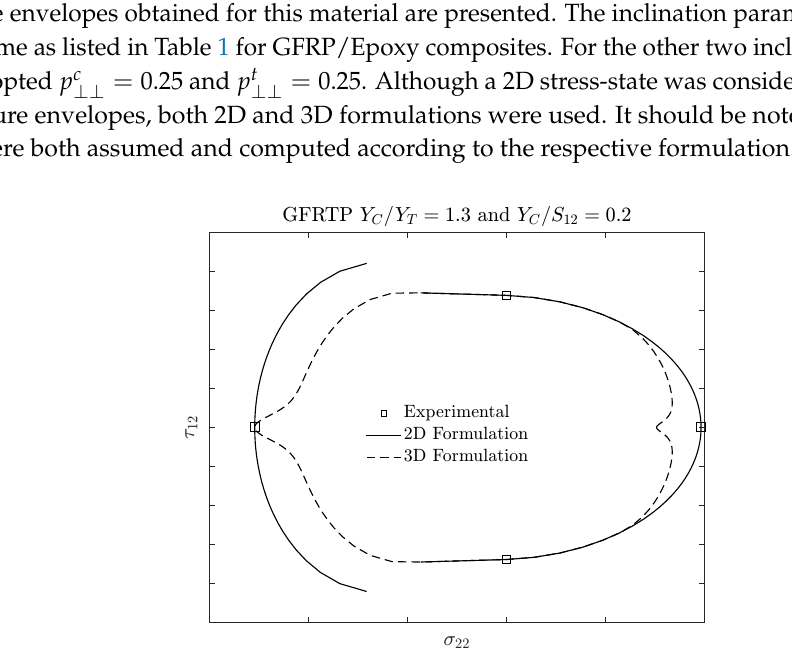
Figure 5. Failure envelopes computed for a 3D-printed glass-fiber composite material using both Puck and Schürmann 2D and 3D